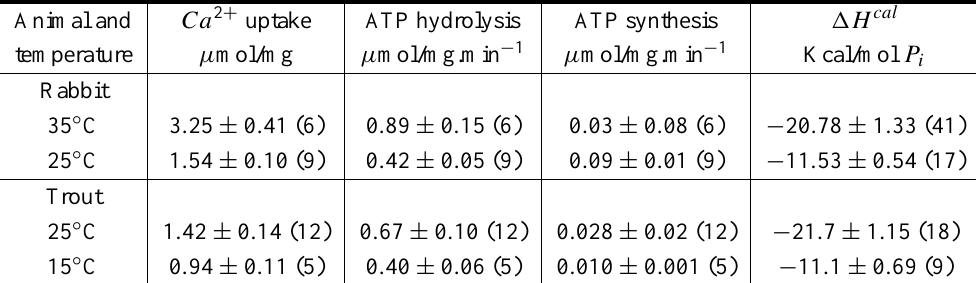
Energy interconversion by the rabbit and trout Ca 2 + -ATPase at different temperatures.